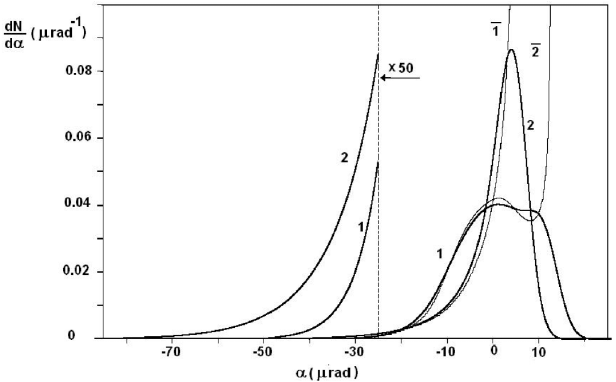
FIG. 9. Distributions of particles after volume reflection and multiple scattering (at the output of a single crystal) as functions of the deflection angle. The zero angle corresponds to the initial direction of a beam. Calculations were made for R (cid:5) 1 m , l (cid:5) 400 GeV . Curves 1 ( (cid:3)1 ) and 2 ( (cid:3)2 ) correspond 0 : 1 cm , and E 0 to positive and negative particles. Curves (cid:3)1 and (cid:3)2 do not take into account multiple scattering. The right tails of distributions are shown in the enlarged scale at 50